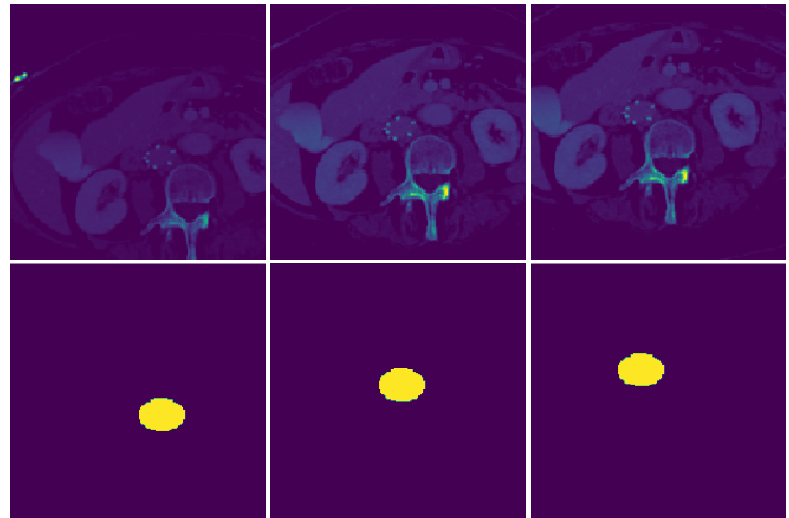
Figure 5. Image augmentation during training process for a CT image slice. These augmentations like random cropping, rotation, and flip reduces spatial bias introduced by the dataset. The masks also undergo similar modifications during